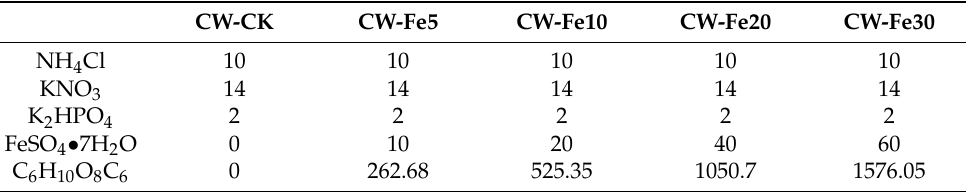
Table 1. The composition and concentration of the synthetic wastewater (mg/L). CW-CK CW-Fe5 CW-Fe10 CW-Fe20